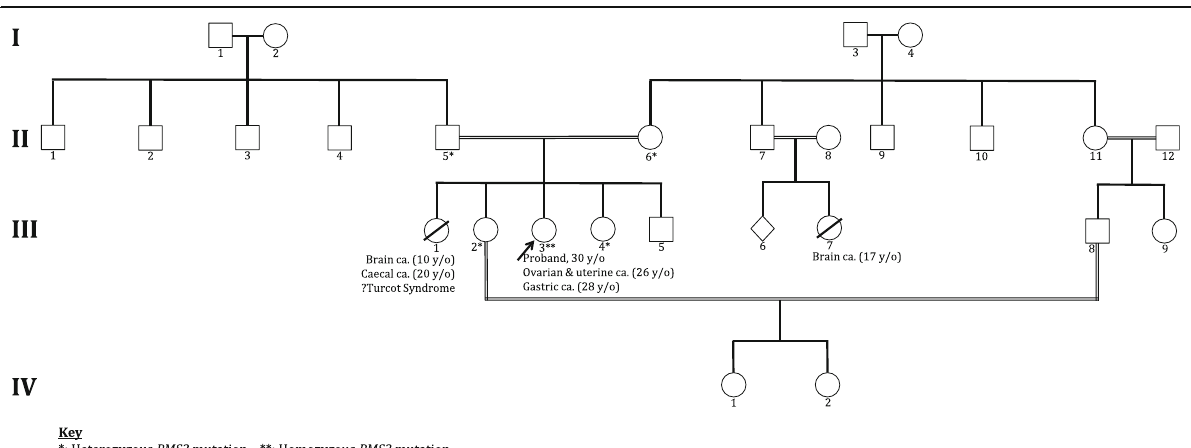
Fig. 1 Family pedigree for the familial PMS2 mutation NM_000535.5:c.1500del (p.Val501TrpfsTer94) in exon 11, of a family of Pakistani ethnic origin living in the UK. The proband ( III:3, arrow) , is homozygous for this PMS2 mutation. She presented with café-au-lait lesions, lichen planus, a dermoid cyst, and bleeding per-rectum. She has developed 37 benign colorectal adenomatous polyps to date. She has developed ovarian and endometrial cancer (both at age 26) and gastric cancer (age 28). III:1 developed a parietal lobe astrocytoma (age 10) and a caecal adenocarcinoma of which she died (age 20); her mutation status is unknown, however III:1 ’ s history is representative of true Turcot syndrome. III:9 died of a brain tumour (age 17); her mutation status is unknown. III:5 has declined genetic testing for the time being. II:5 and II:6, II:7 and II:8 , II:11 and II:12 are distant